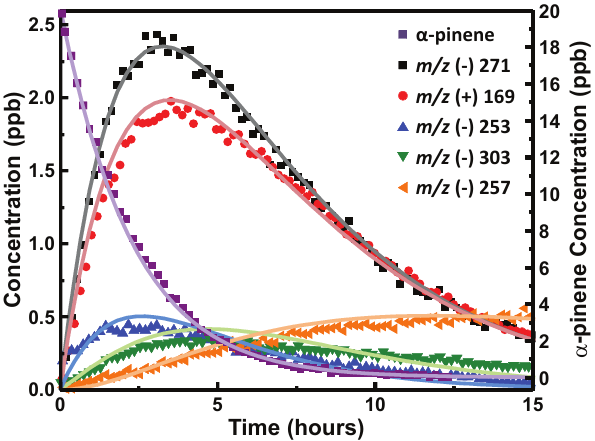
Fig. 5. Time-dependent observed (points) versus simulated (lines) concentrations from the photooxidation of 19.8ppb of α -pinene. Represented are α -pinene (purple), α -pinene hydroxy hydroperox- ide (black), pinonaldehyde (red), α -pinene hydroperoxide (blue), α - pinene hydroxy dihydroperoxide (green), and the C 9 hydroperoxide from pinonaldehyde (orange). See the Supplement for structural in- formation and kinetic model.